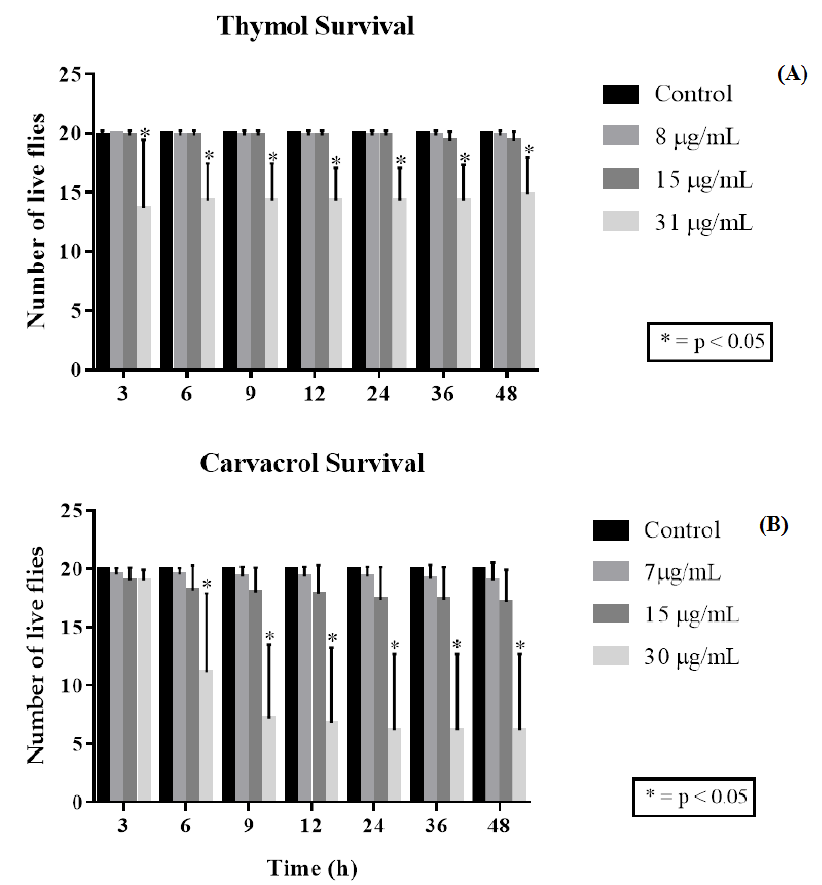
Figure 3. Toxic e ff ect of di ff erent thymol ( A ) and carvacrol ( B ) concentrations on D. melanogaster Figure 3. Toxic effect of different thymol ( A ) and carvacrol ( B ) concentrations on D. melanogaster .